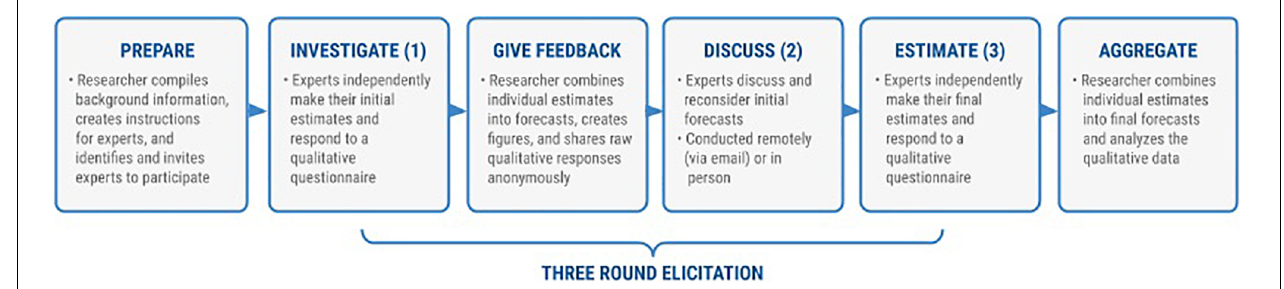
FIGURE 2 | The elicitation format – The Delphi format elicitation consisted of a preparation stage, the three-round elicitation (numbered 1, 2, 3), and final data aggregation and analysis. Quantitative and qualitative data were collected during steps one and